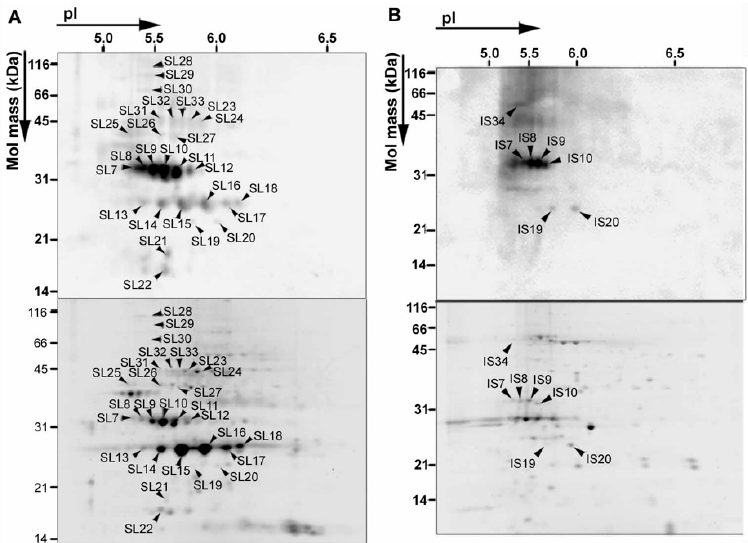
Figure 4. 2D PAGE gel patterns of chloroplast proteins extracted from + NO 2 -treated plants. The stromal and lumenal protein fraction ( A ), and the thylakoid membranous protein fraction ( B ) are shown. Spots on gel ( A ) and ( B ) were numbered as SLn and ISn, respectively. Upper and lower panels of ( A ) and ( B ) correspond to Western blots detected using 3-NT-specific antibody and gels stained with SYPRO Ruby, respectively. Each lane of stromal and lumenal protein fraction and thylakoid membranous protein fraction was loaded with 40 and 20 µ g protein, respectively.